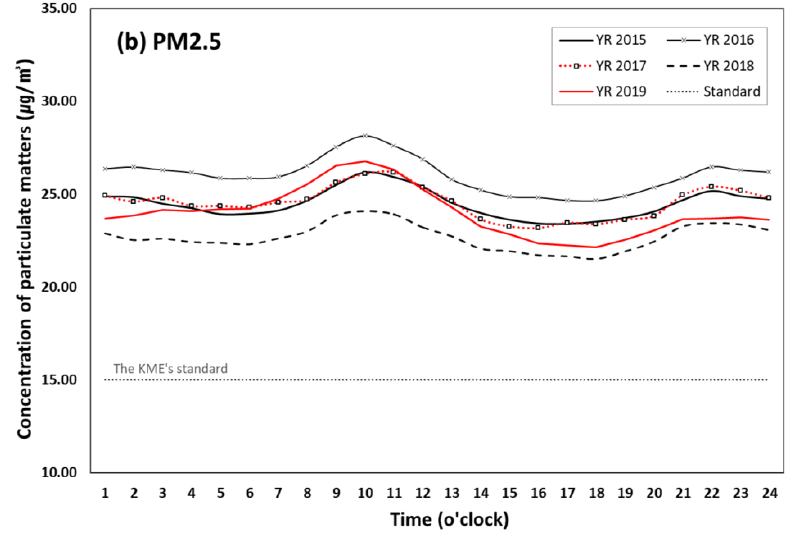
Figure 2. Diurnal variation of particulate matter (PM) concentrations (µg/m 3 ) by year (all regions).